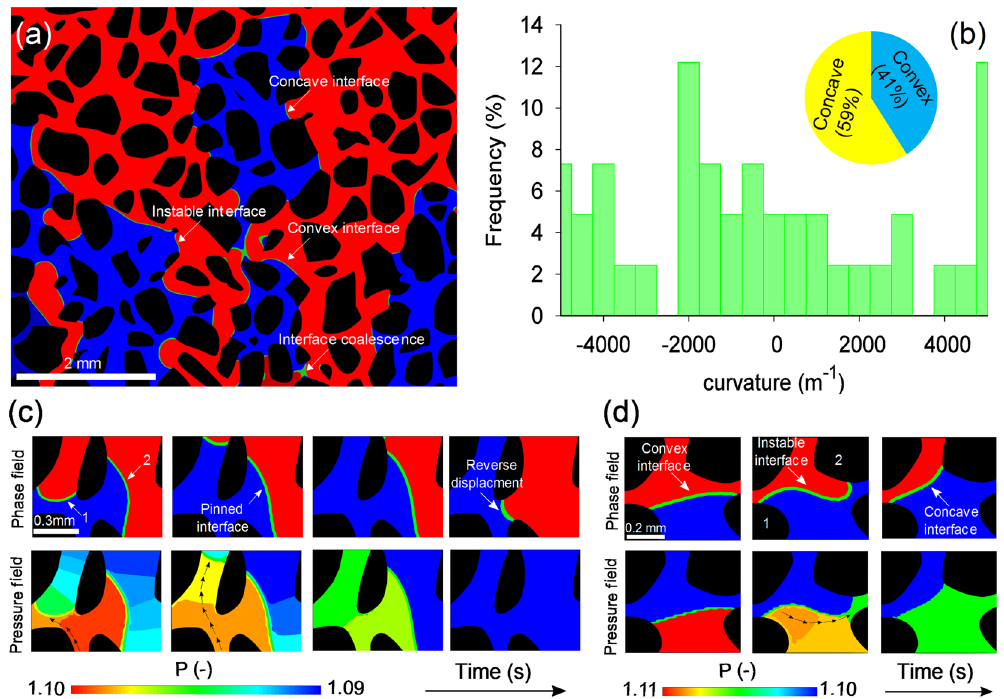
Figure 1. ( a ) The main interfacial features observed during immiscible two-phase flow in intermediate-wet porous media ( θ = 60°) at 2.8 s. ( b ) Curvature distribution of interfaces shown in Fig. 1(a). ( c ) Dynamics of concave (labelled as “1”) and convex (labelled as “2”) interfaces during displacement in the porous medium with θ = 60°. Pinning of convex interface and reverse displacement mechanism as a result of co-existence of concave and convex interface is observed. ( d ) Interface instability in a single pore. In the phase distribution shown in Fig. 1(a,c,d), red, blue and green represents defending fluid, invading fluid and the fluid-fluid interface, respectively. The pressure field shown in Fig. 1(c–d) indicates the pressure values normalized with respect to the outlet pressure. The direction of injection in all images is from bottom to